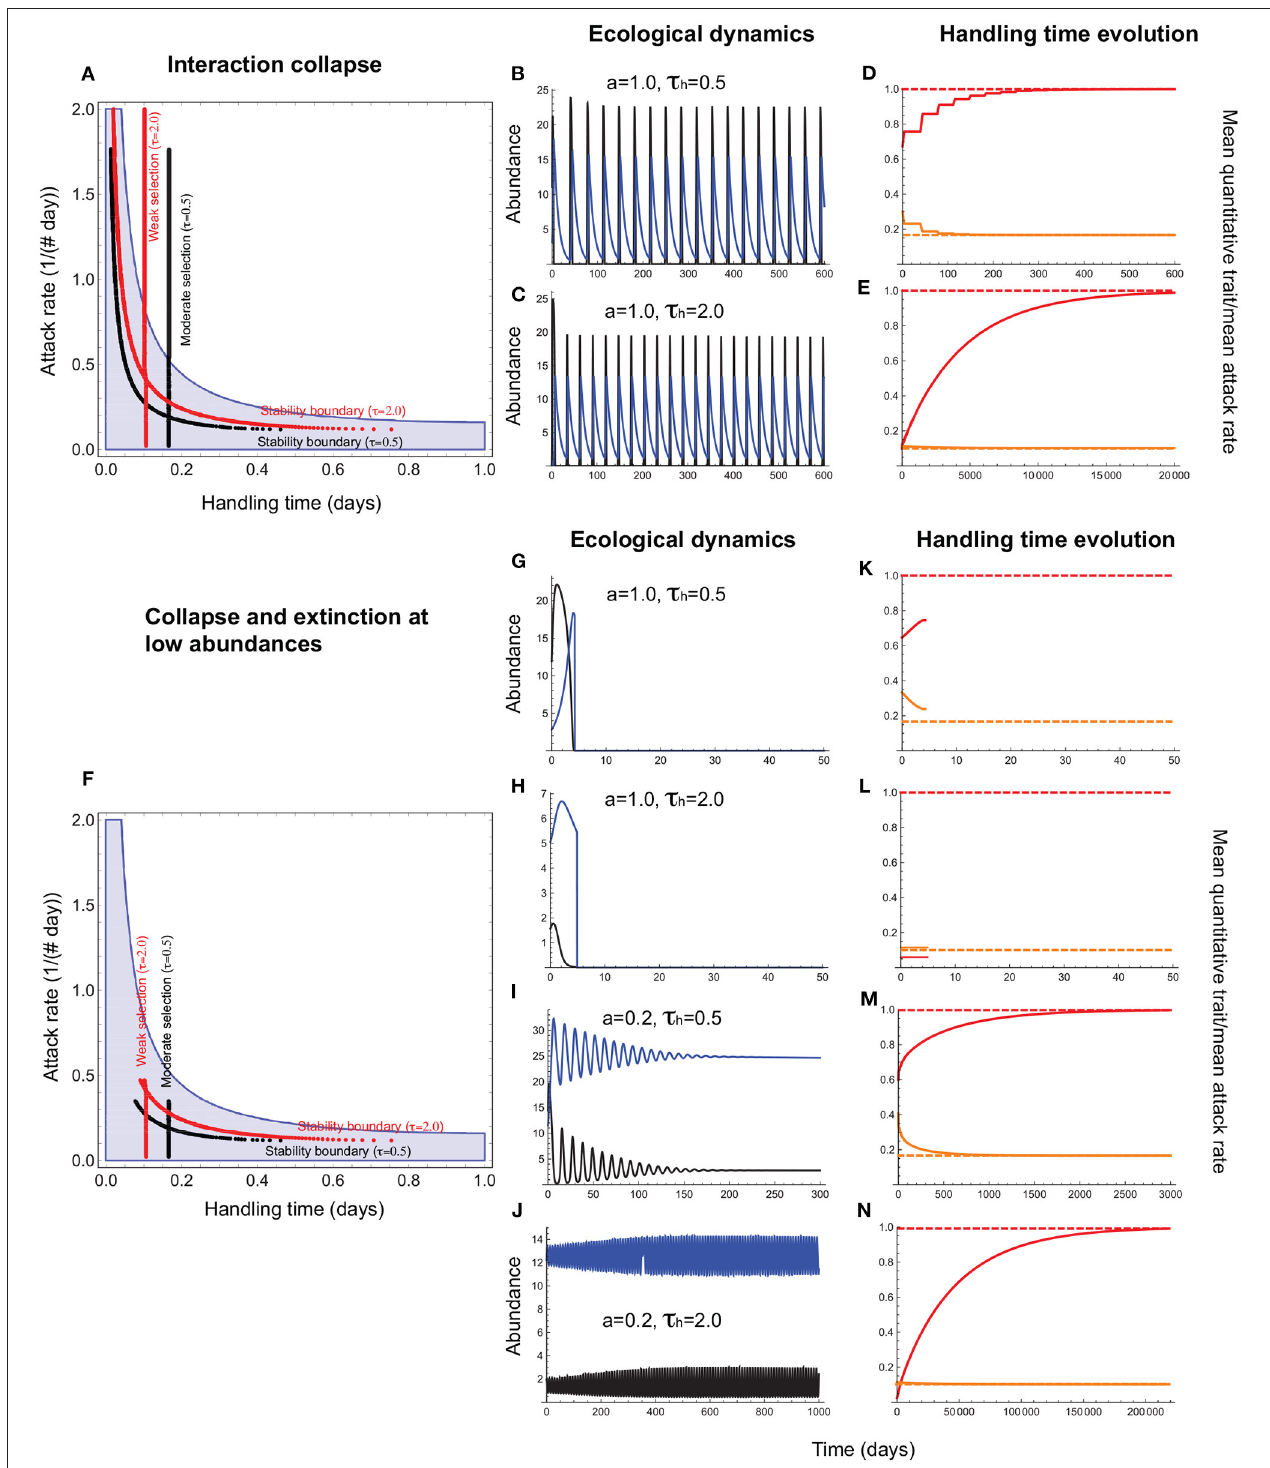
FIGURE 5 | Handling time evolution when it is a consumer trait. (A–E) depict outcomes under collapse, and (F–N) , collapse combined with extinction at low abundances. In (A,F) , the red and black vertical lines depict the attack rate-handling combinations that evolve in the model for weak ( τ h ( τ h 0.5) selection. The red and black curves represent the corresponding stability boundaries calculated using these evolved combinations. The blue shaded region = depicts the attack rate-handling time combinations that yield a stable point equilibrium in the absence of evolution. In (A,F) , the mean handling time ( h ( y )) evolves